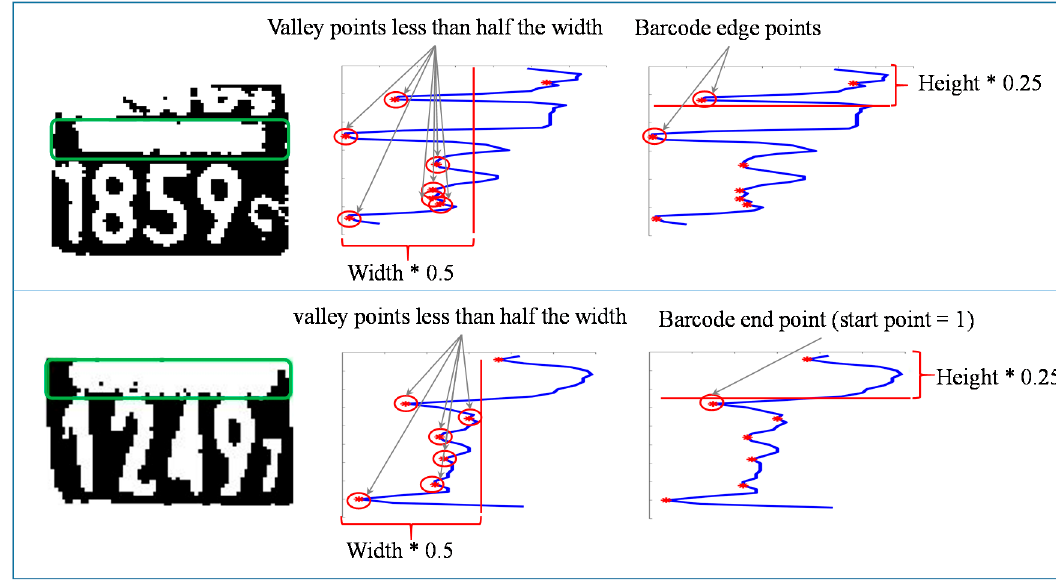
Figure 11. Barcode area detection process.